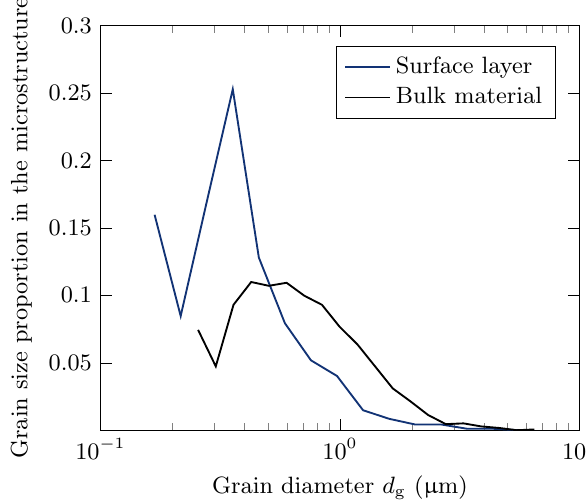
Figure 15. Grain diameter distribution in the bulk material and the surface layer for a − 5 ◦ rake angle γ (cid:48) o of the minor cutting edge ( v c = 250m/min, f z = 0.015mm, a p = 0.25mm, a e = 0.5mm, α (cid:48) o = 2 ◦